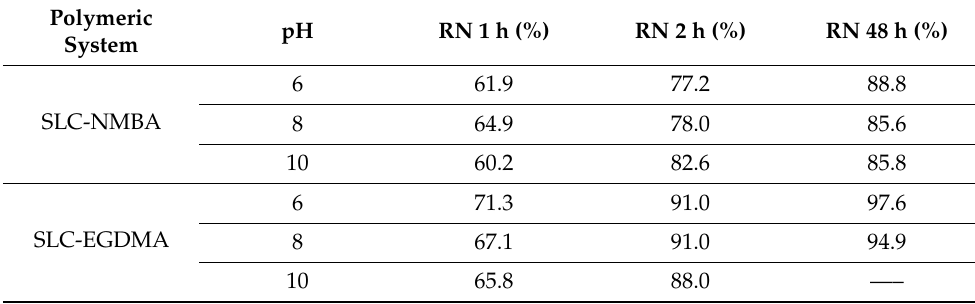
Table 4. Nitrate Release percentages at different time intervals and pH a .